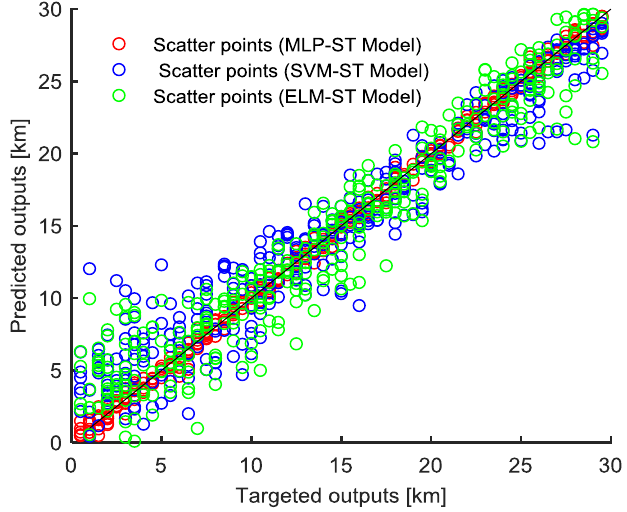
Figure 5 . Scatter plot of the targeted and the ST based non-optimized MLT predicted Figure 5. Scatter plot of the targeted and the ST based non-optimized MLT predicted outputs, for the outputs, for the test dataset of AG fault. test dataset of AG Table 4. Operation time and statistical performance indices for test datasets with randomly selected MLT parameters.